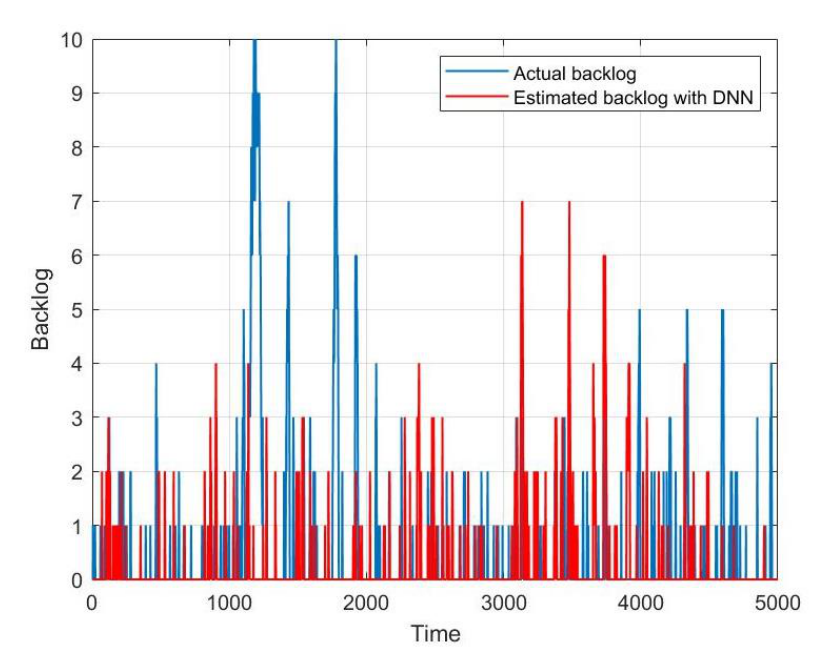
Figure 11. Backlog vs. time.